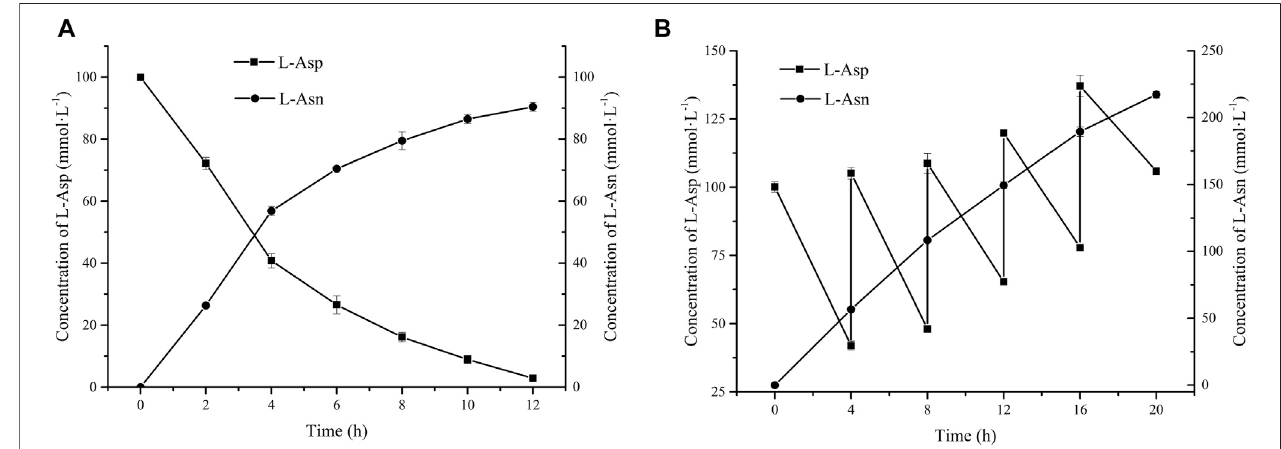
FIGURE 4 | Effects of feeding substrates on whole cell catalytic preparation of L-Asn. (A) Sodium hexametaphosphate (60 mmol L − 1 ) was added at 4 and 8 h, respectively. (B) Sodium hexametaphosphate (60 mmol L − 1 ) and L-Asp (60 mmol L − 1 ) were added at 4, 8, 12, 16, and 20 h, respectively.